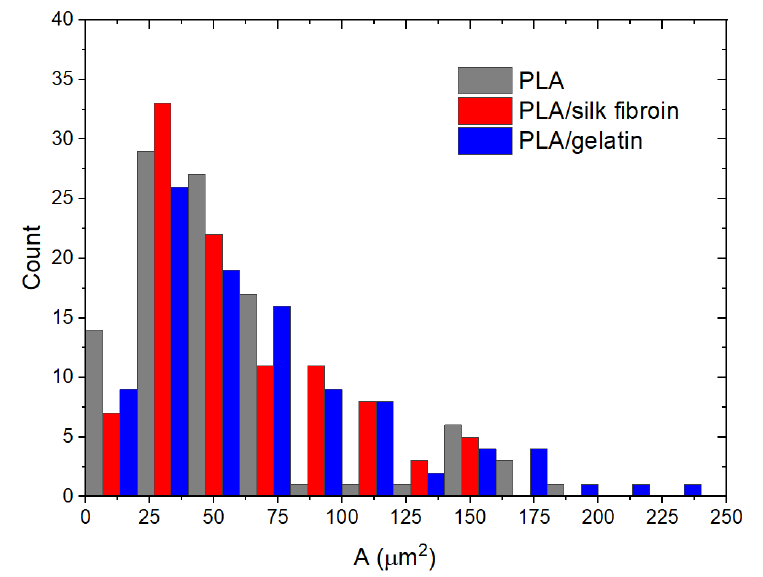
Figure 6. Pore area distribution of the melt electrospun PLA and modified PLA scaffolds.